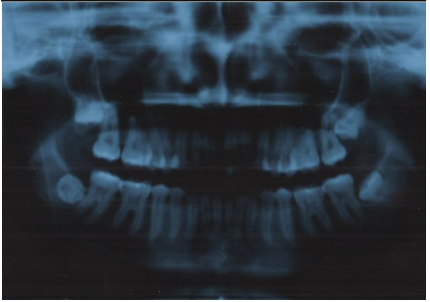
Figure 1: X-ray before any intervention.